Question: Does the figure show an increasing or a decreasing trend?
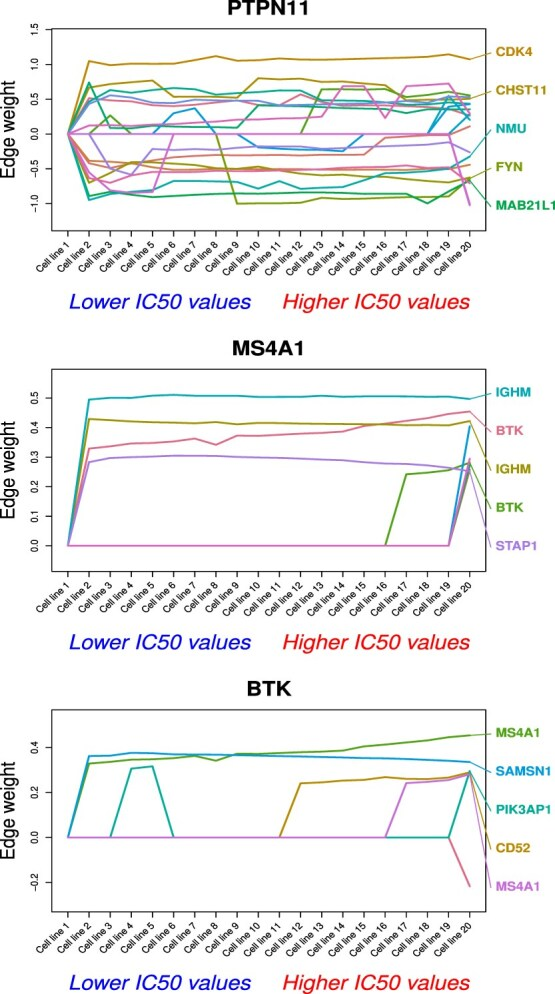
Answer: increasing